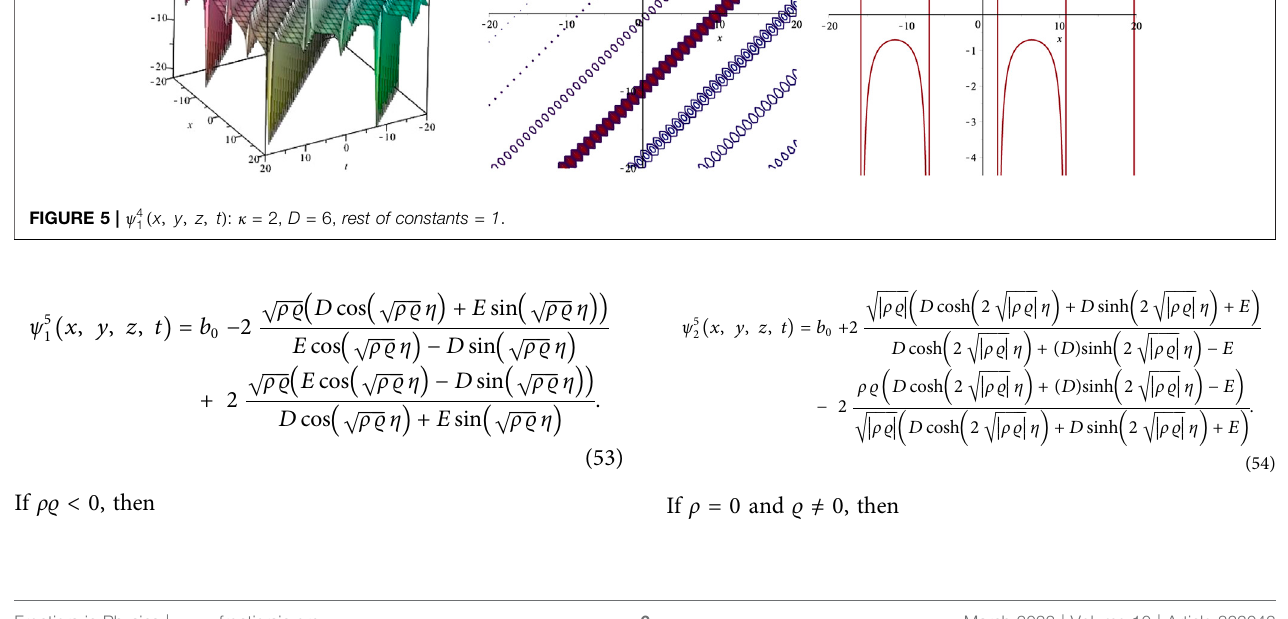
Frontiers in Physics |